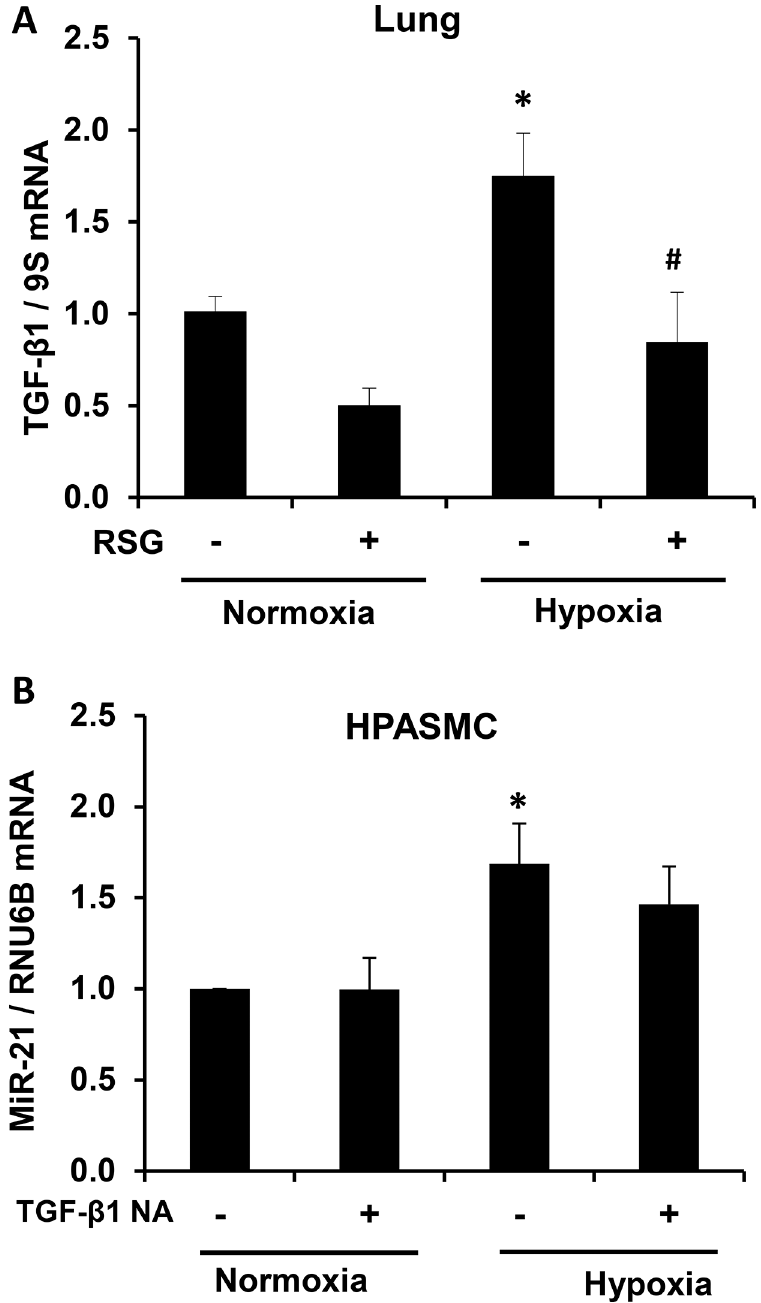
Fig 7. Rosiglitazone attenuates hypoxia-induced TGF- β 1 expression. (A) Mice were exposed to normoxia or hypoxia for 3 weeks and treated with vehicle or RSG during the last 10 days, and (A) TGF- β 1 mRNA was quantified. (B) HPASMC pre-treated with TGF- β 1 neutralizing antibodies (1 μ g/ml) for four hours were placed into a hypoxia chamber for 48 hours and miR-21 expression was quantified. Each bar represents mean ± SEM (A) TGF- β 1 mRNA or (B) miR-21 levels. * P < 0.05 vs Normoxia (-), # P < 0.01 vs Hypoxia (-) (n = 5 –